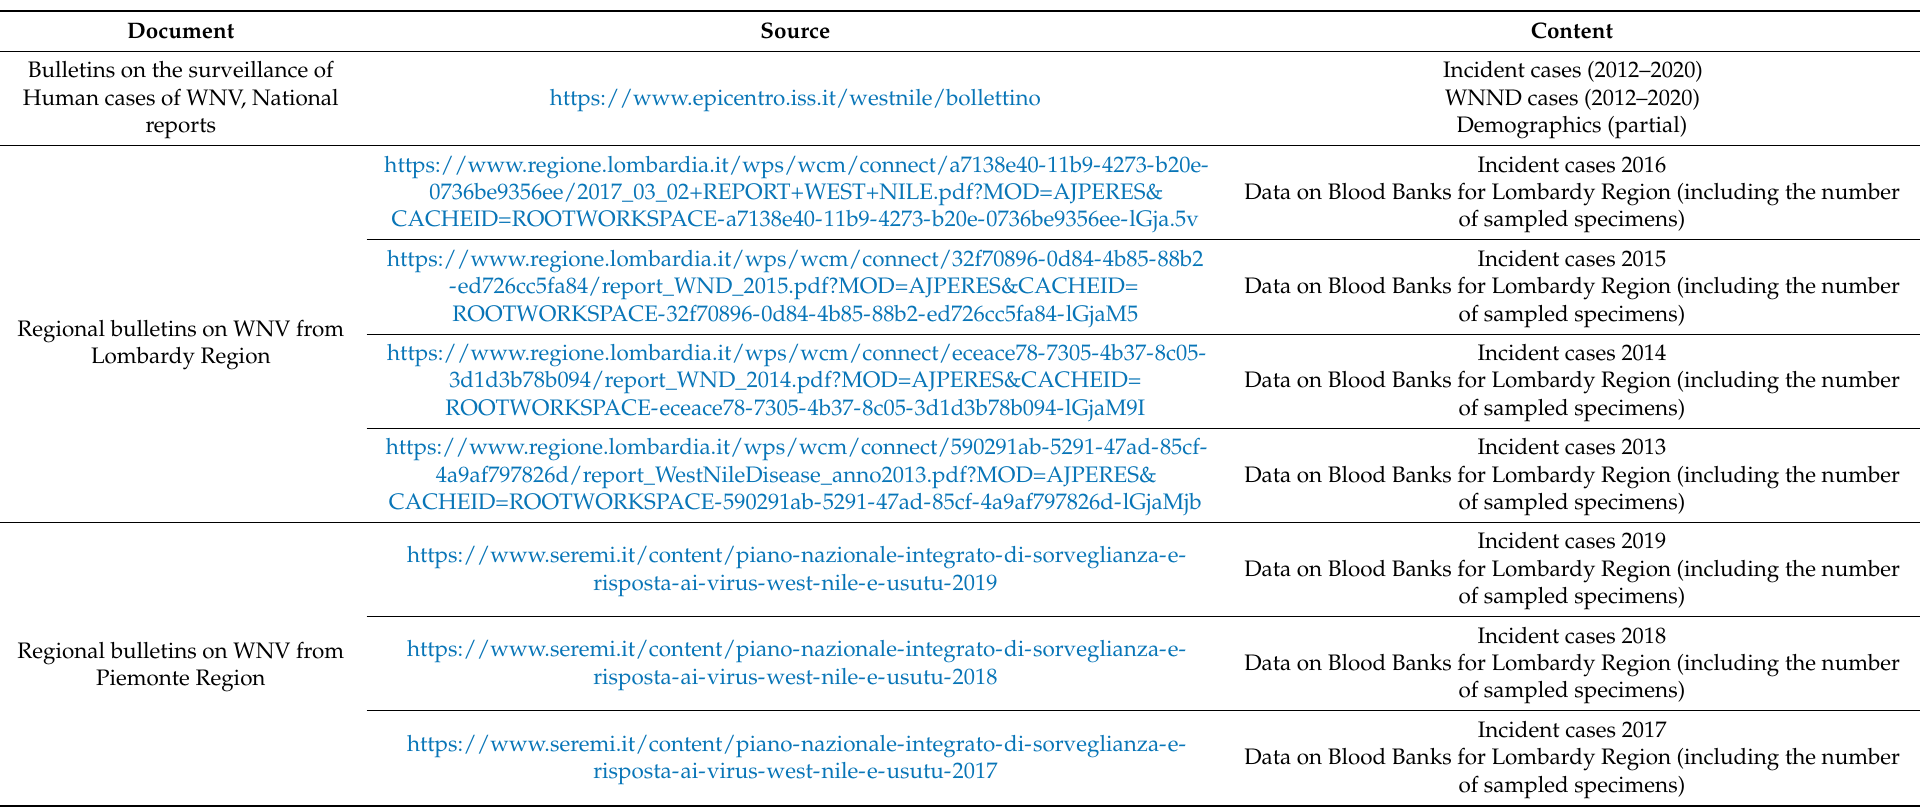
Table A1. Source of Official Bulletins Included in the Study (all Link were Verified on 23 April